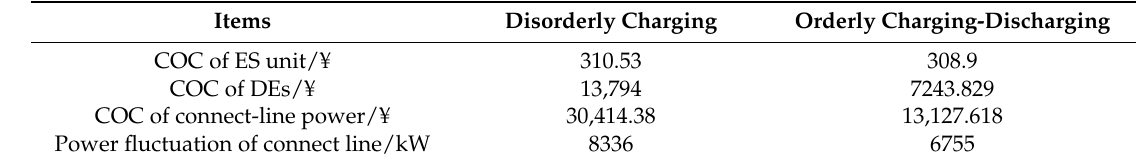
Table 1. Comparison of simulation